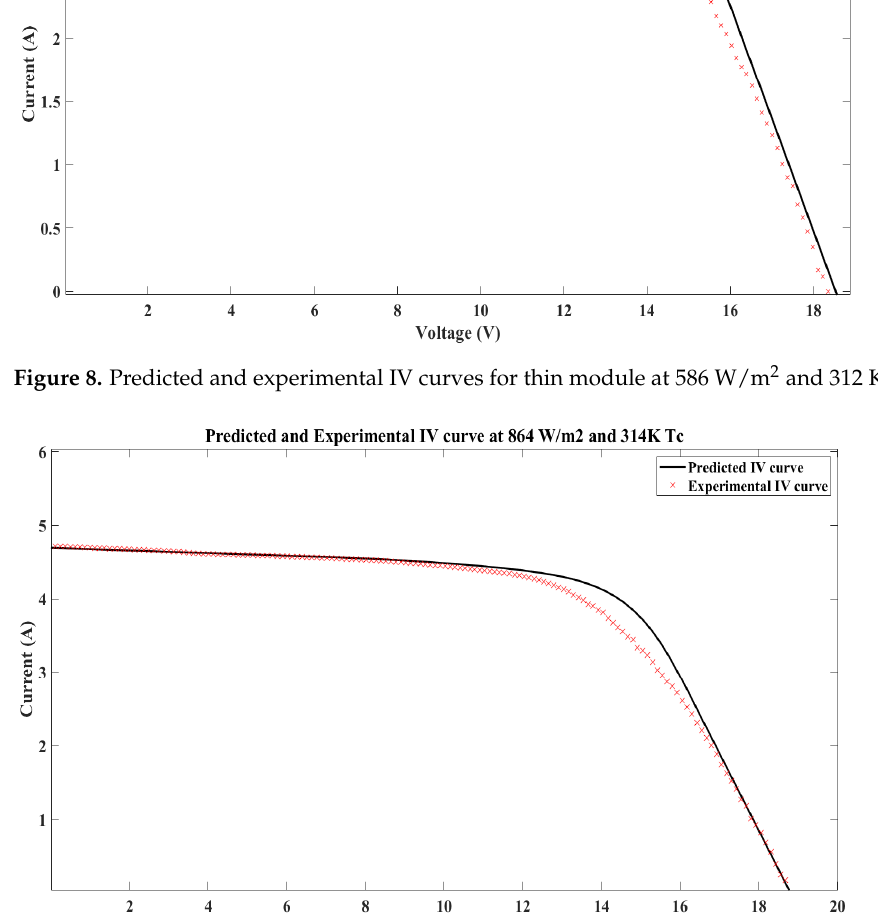
Figure 10. Predicted and experimental IV curves for polycrystalline module at 410 W/m 2 and 316K Tc.